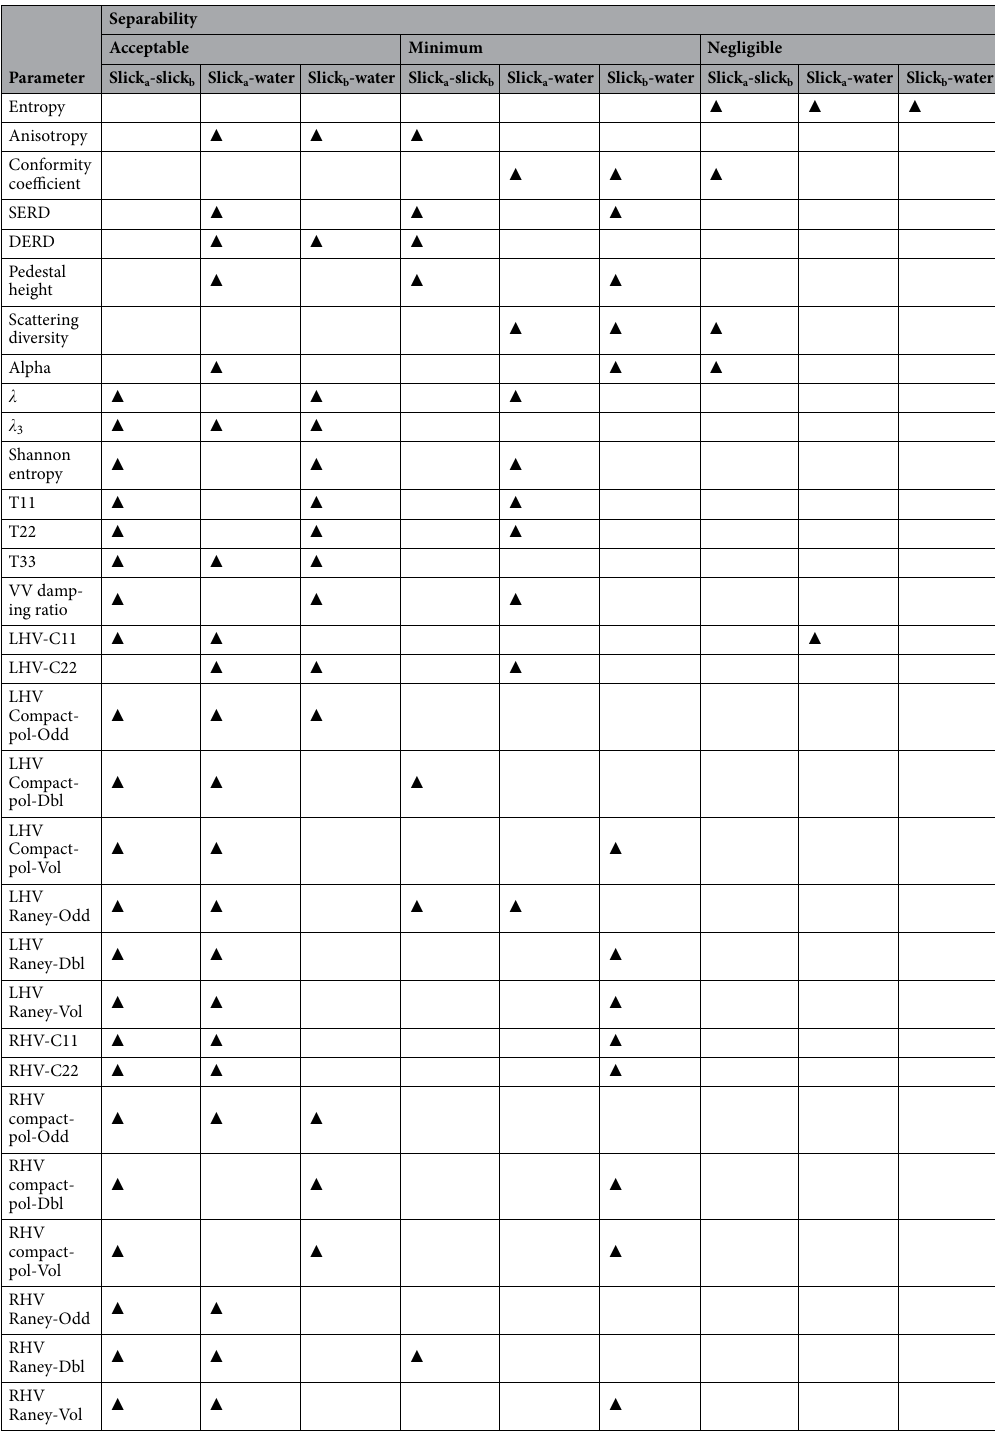
Table 4. Achieved separability extent for water-slick pairs against each